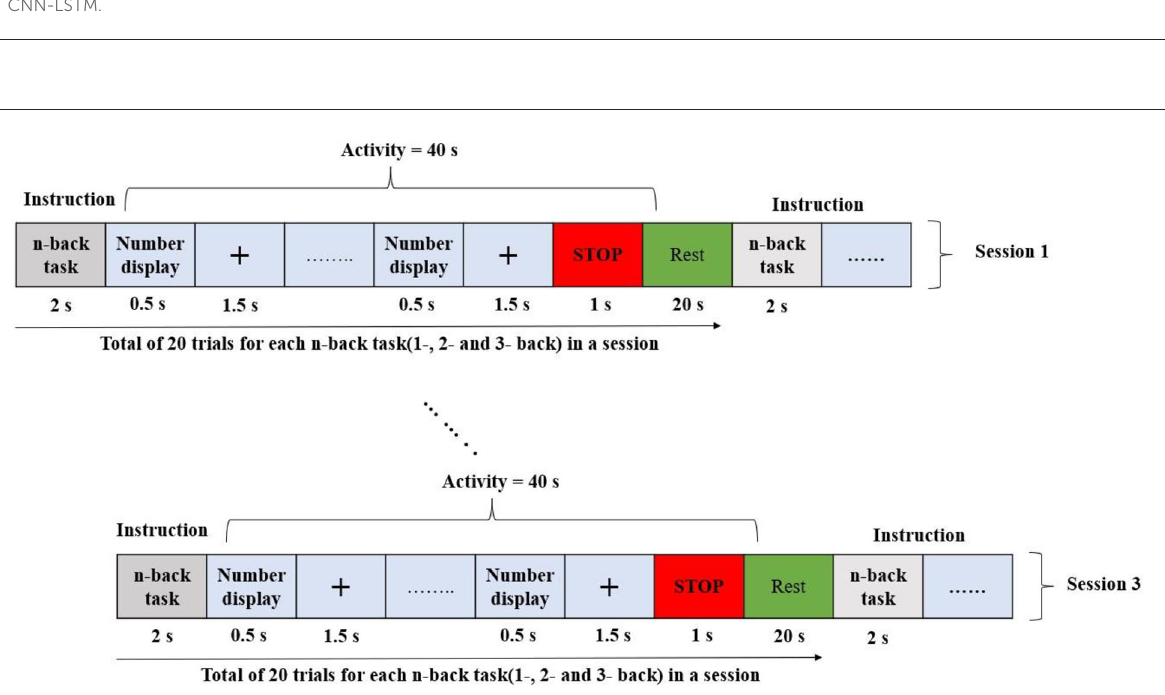
of 1–40 Hz was used for filtering purposes. The acquired data were first translated into oxy- and deoxy-hemoglobin intensity variations to pre-process the fNIRS data. The conversions were conducted using the modified Beer–Lambert law. The fNIRS raw data were downsampled at 10 Hz. As the fundamental frequency of this dataset was very low, the downsampled data were not fed into the Butterworth bandpass filter. Instead, the data were low-pass filtered to avoid losing the fundamental frequency component. The cutoff frequency of the filter was